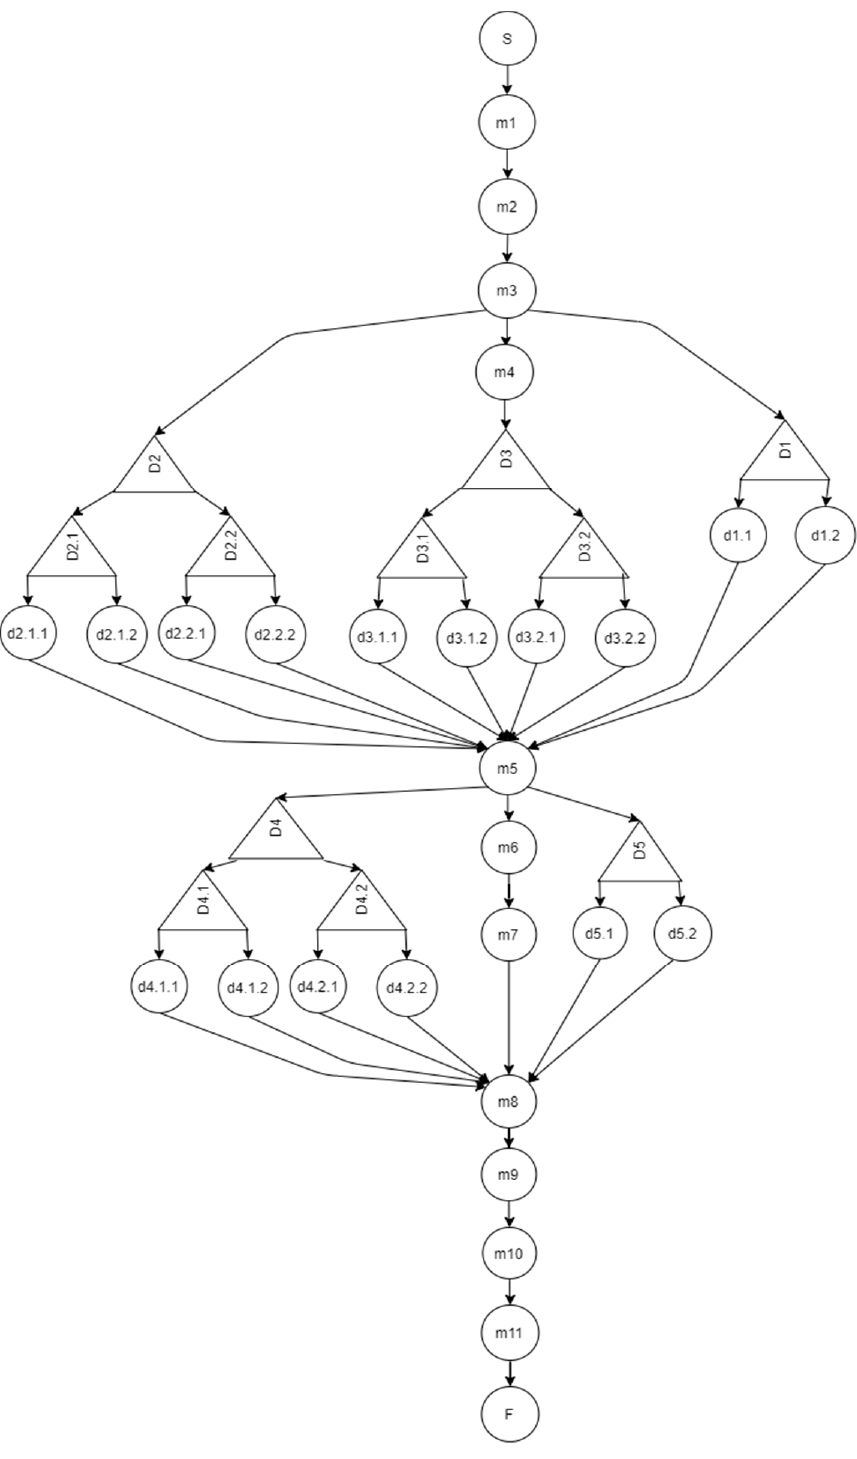
Figure 7. An alternative graph of the project of creating a vertical farm system with several technical levels. Source : designed by authors.